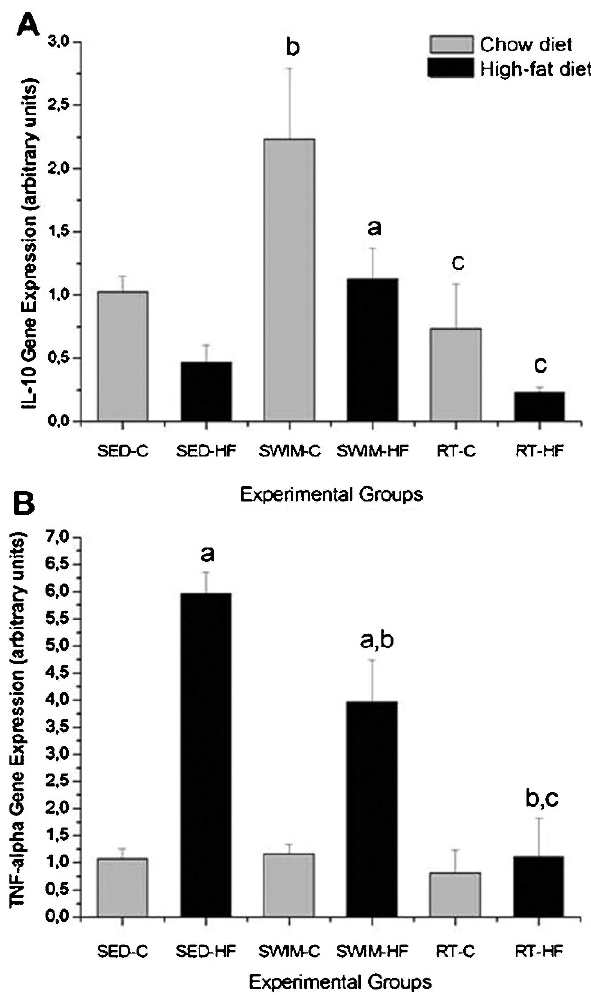
Figure 3 - IL-10 (A) and TNF-alpha expression (B). All values are presented as means ¡ standard error of the mean; a p # 0.05 compar- ing normal chow diet vs high-fat diet groups; b p # 0.05 comparing sedentary vs trained groups; c p # 0.05 comparing swimming